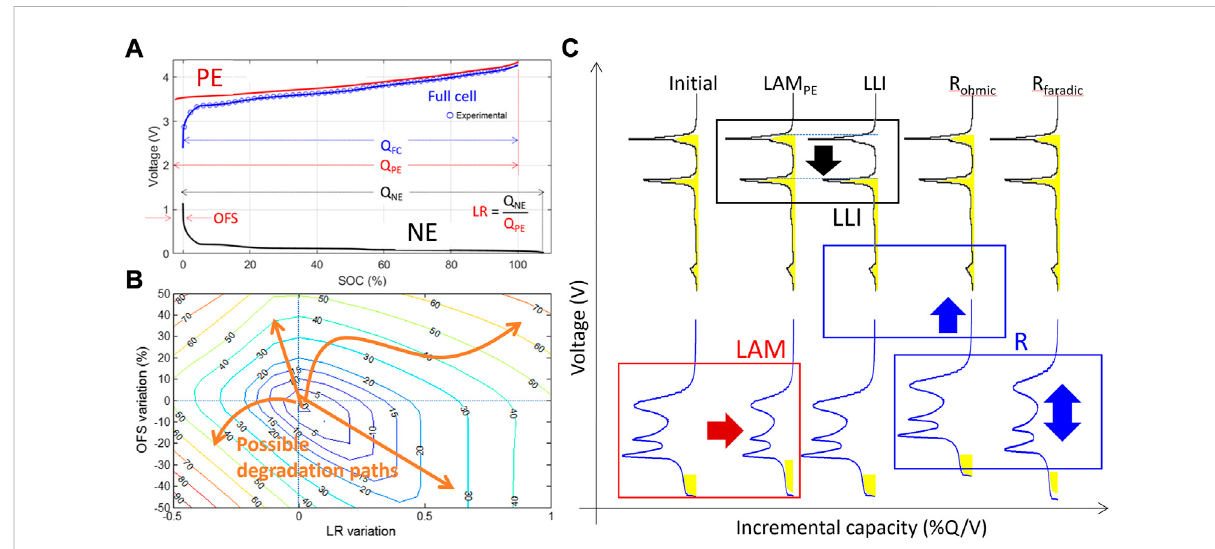
FIGURE 4 (A) Representation of the relationship between the PE, NE, and full cell. (B) Exemplary contour plot showcasing evolution of capacity loss as a functionofthevariationsofLRandOFS. (C) ClepsydraanalogyfortheimpactofLAM,LLI,andRchanges,bothohmicandfaradic.AdaptedfromBarai et al. (2019); Dubarry and Baure